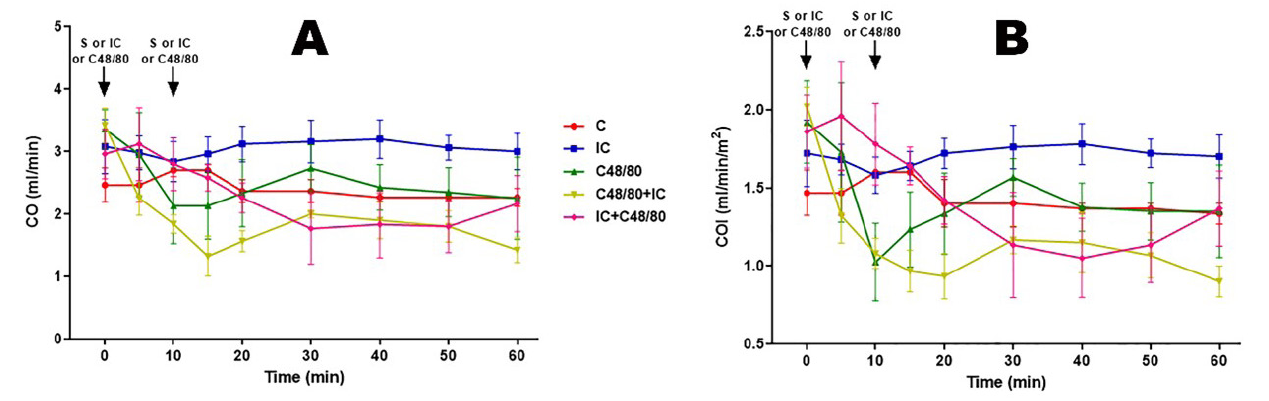
Fig. 2 - Cardiac output. Effect of anaphylactic shock caused by compound 48/80 (C48/80) and treated with indigo carmine (IC) in pigs. A) Cardiac output (CO); B) cardiac output index (COI). At minute 0, the control (C) group received saline (S), the C48/80 and C48/80 + IC groups received C48/80, the IC and IC + C48/80 groups received IC. At minute 10, the C, IC, and C48/80 groups received S, the C48/80 + IC group received IC, and the IC + C48/80 group received C48/80. Data represent means ± standard error of mean and analyzed by two-way analysis of variance (ANOVA), Dunnett post-test (n=5). No statistical difference was observed.